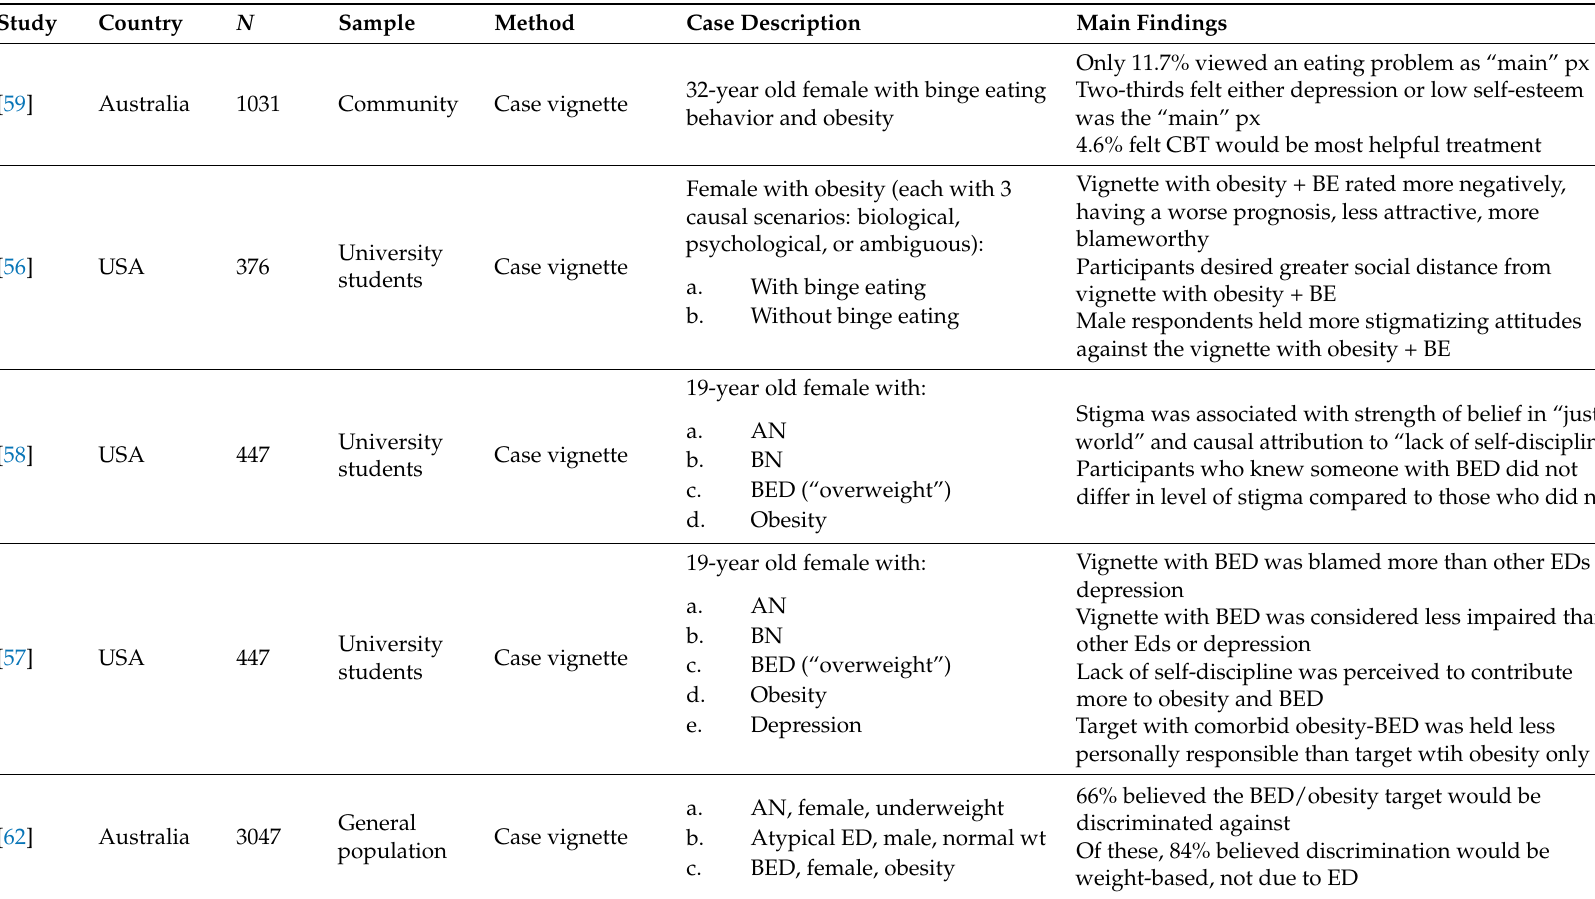
Table 1. Study characteristics of investigations of community attitudes and knowledge of binge eating disorder